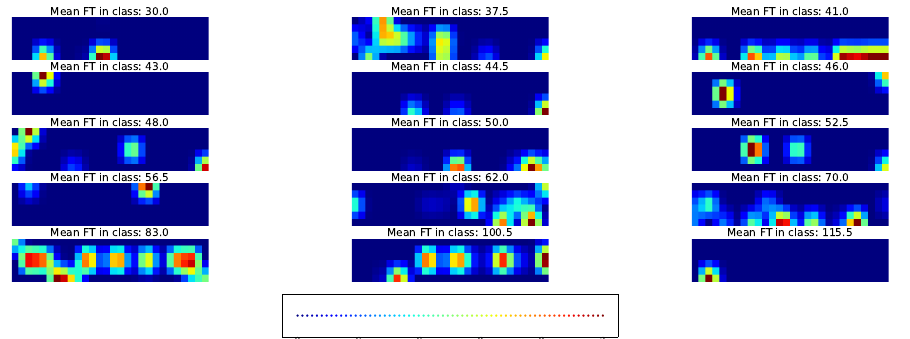
Figure 12. Example of the Score-CAM map for individual acccessions in each time class and cross-SNP set. Figure S3 gives the same data with higher magnification.